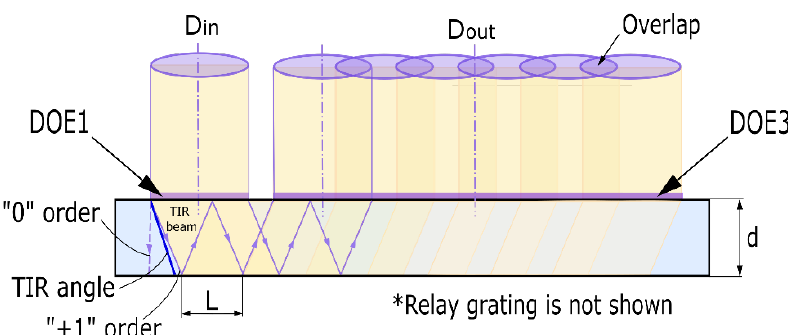
Figure 2. Geometry and ray propagation in the substrate: D in is the diameter of the entrance pupil of the substrate, D out is the diameter of the exit pupil of the substrate, L is the beam stoke length.